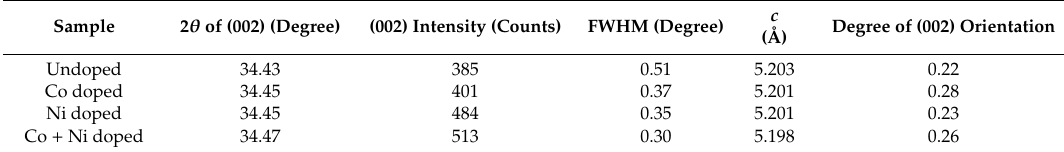
Table 1. Parameters of ZnO NR crystals extracted from XRD